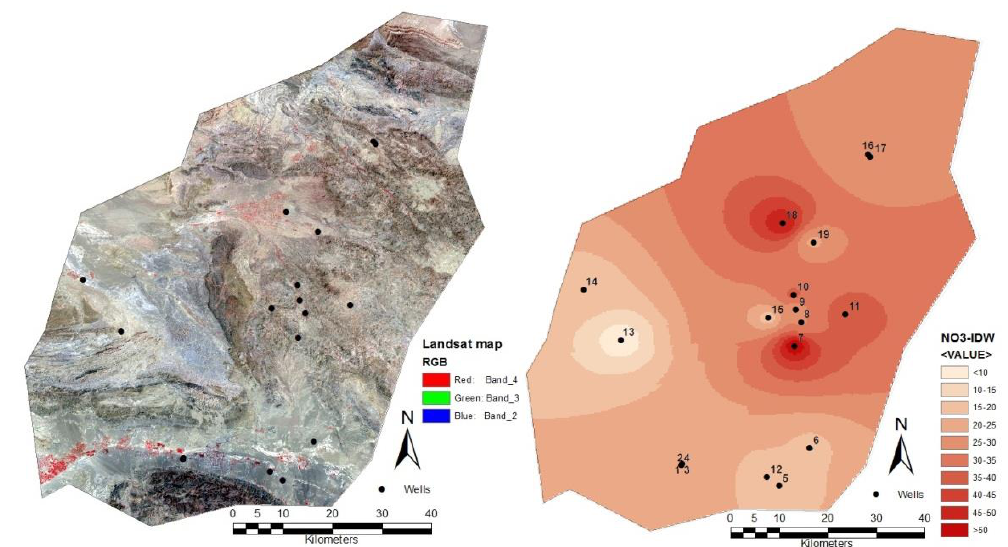
Figure 3. RBG color image using combination of bands 4 (red), 3 (green) and 2 (blue)